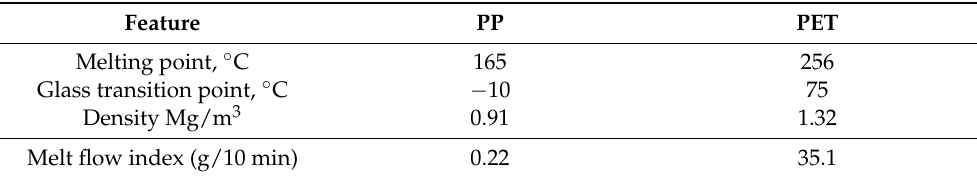
Table 2. Plastomers basic properties.